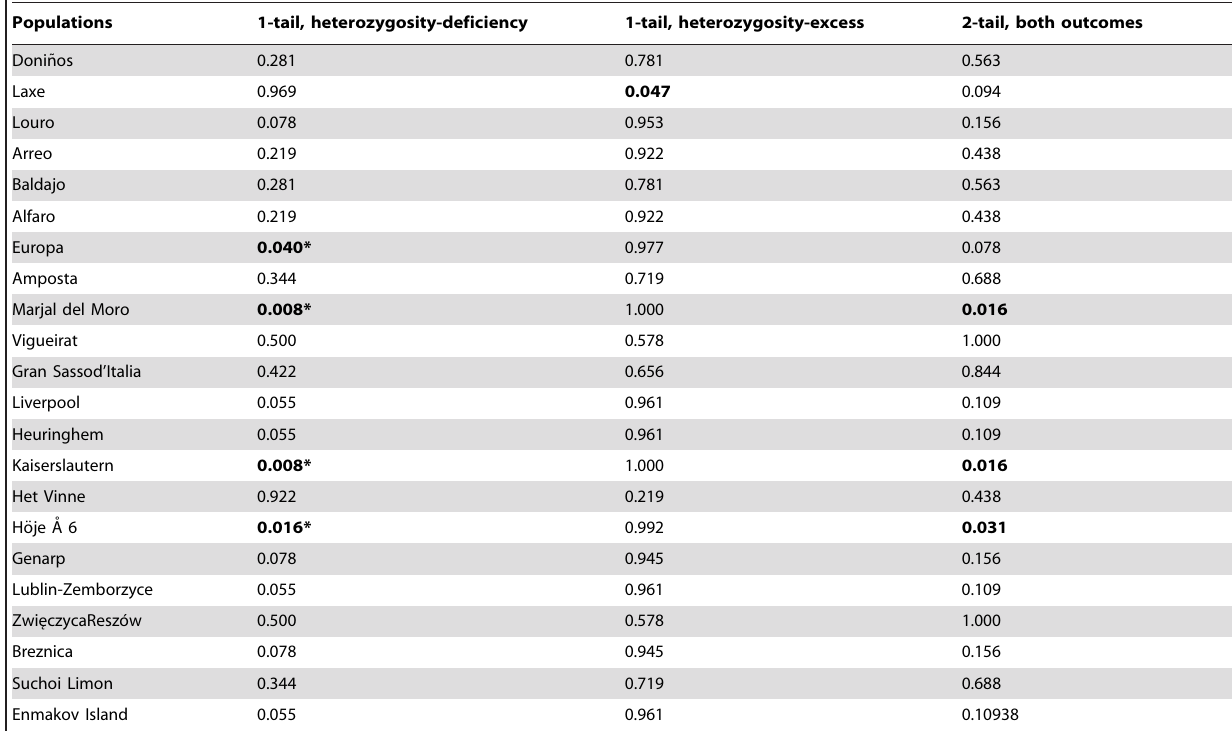
Table 5. Test results from the program